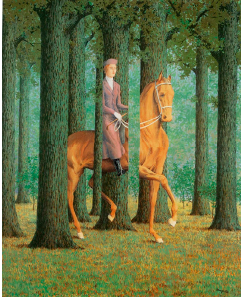
Figure 20. R. Magritte, Le blanc seign ,